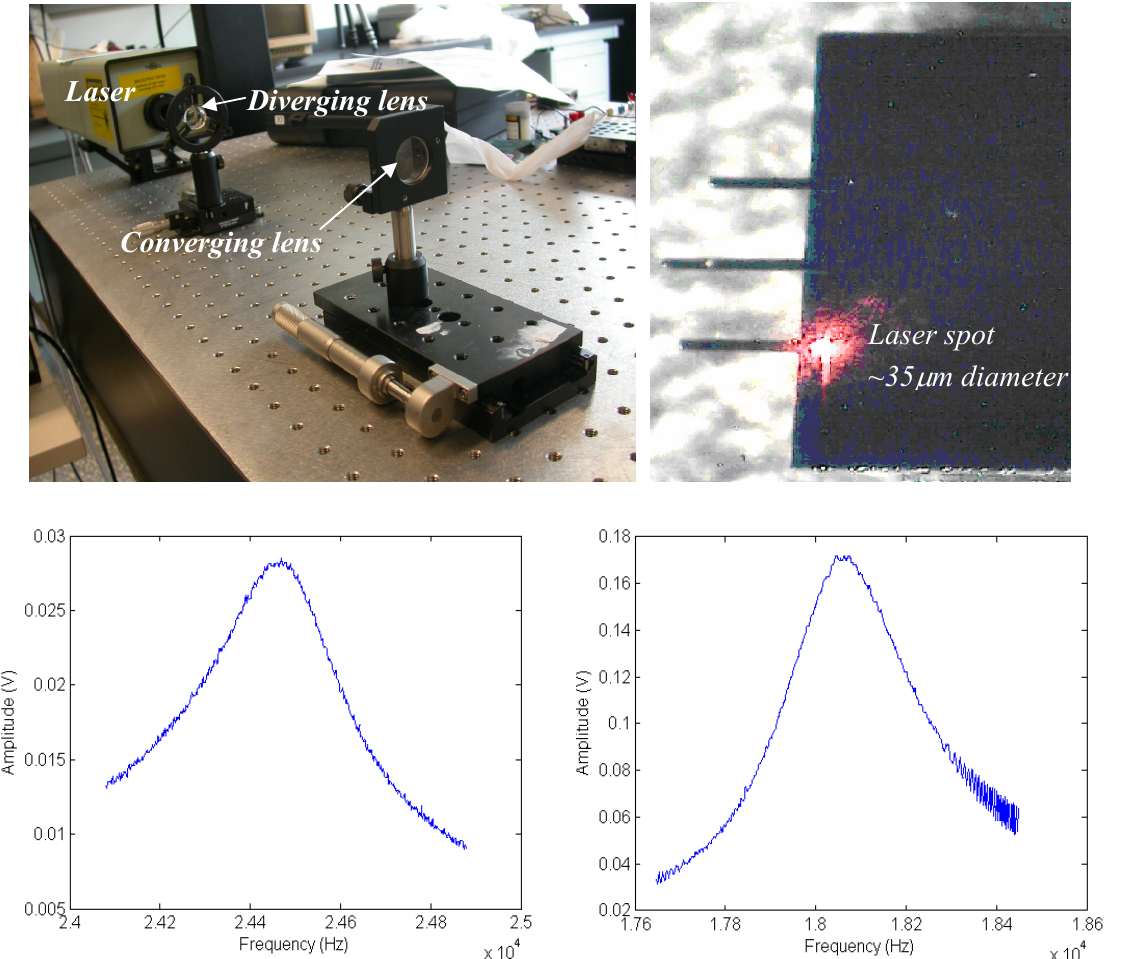
Figure 8. Top left: HeNe laser and lenses mounted on an optical bench. Top right: Digital image taken through a microscope of the laser spot on the AFM chip. Bottom: Sample responses obtained with the experimental method used in this